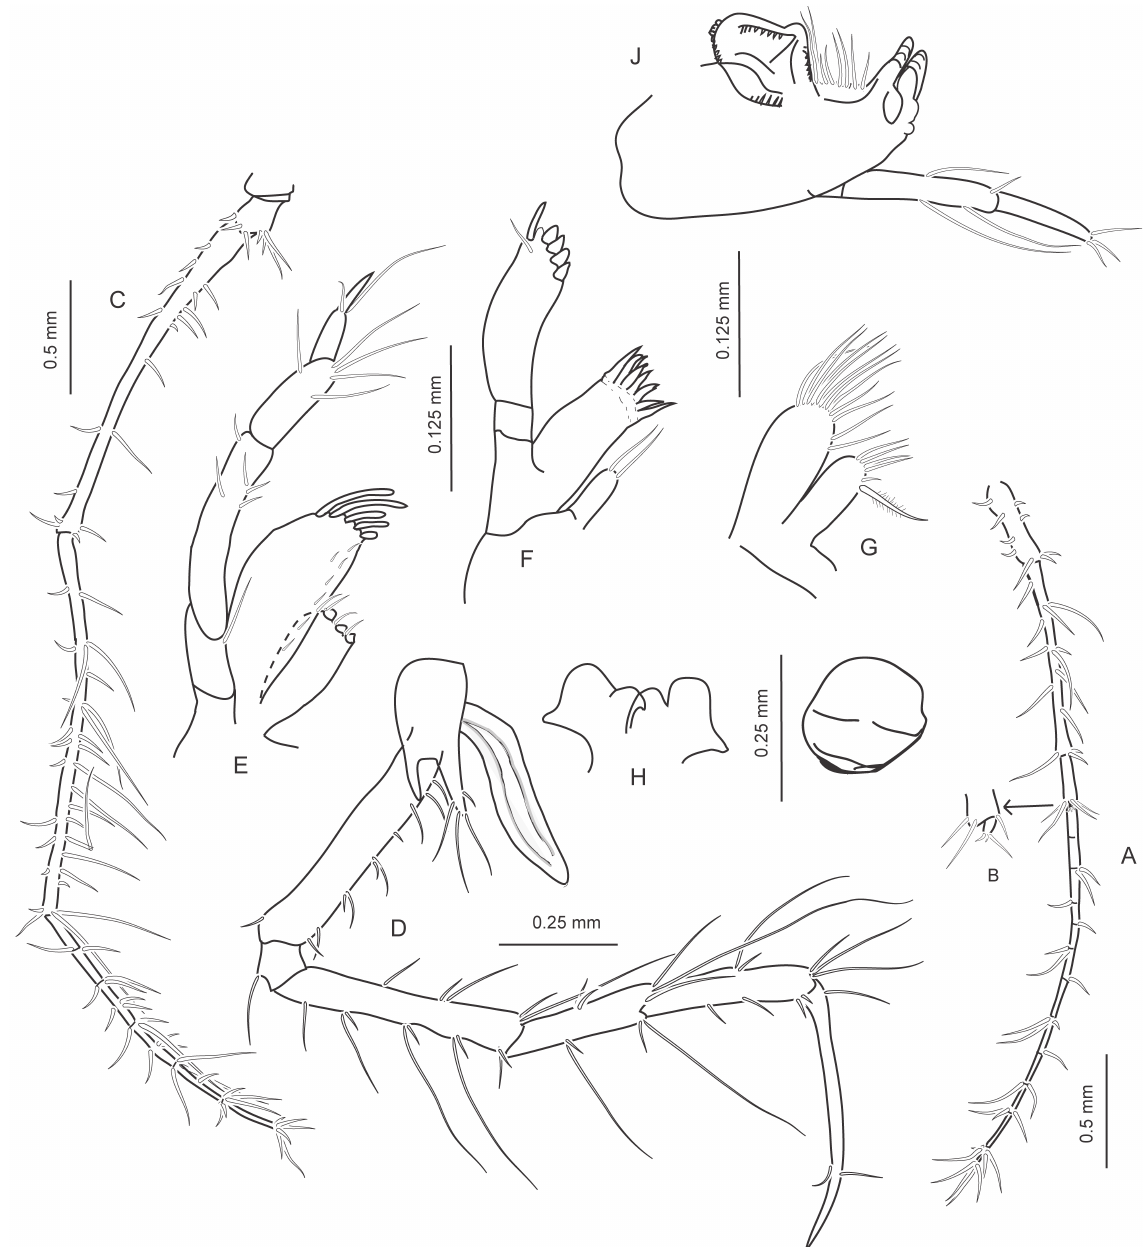
Fig. 18. Lepesubchela christinae gen. et sp. nov., holotype, immature. A–B . A1 with accessory flagellum. C . A2. D . Right P3 with gill. E . Left Mxp. F . Left Mx1. G . Left Mx2. H . Lower lip. I . Upper lip. J . Right